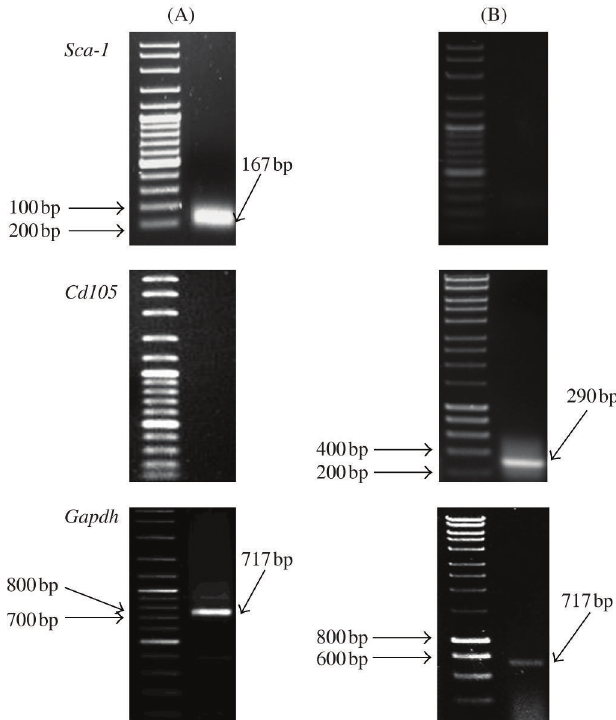
FIGURE 2: Activation of stem cell markers and housekeeping gene in suspension and adherent mononu- cleated cells. Activation of the hematopoietic stem cell marker ( Sca-1 ), mesenchymal stem cell marker ( Cd105 ), and housekeeping gene ( Gapdh ) in suspension mononucleated cell populations (A) and adherent mononucleated cell populations (B). Only Sca-1 was found to be activated in suspension cells, while only Cd105 was activated in adherent cells Gapdh , the housekeeping gene and positive control, was active in both types of mononucleated